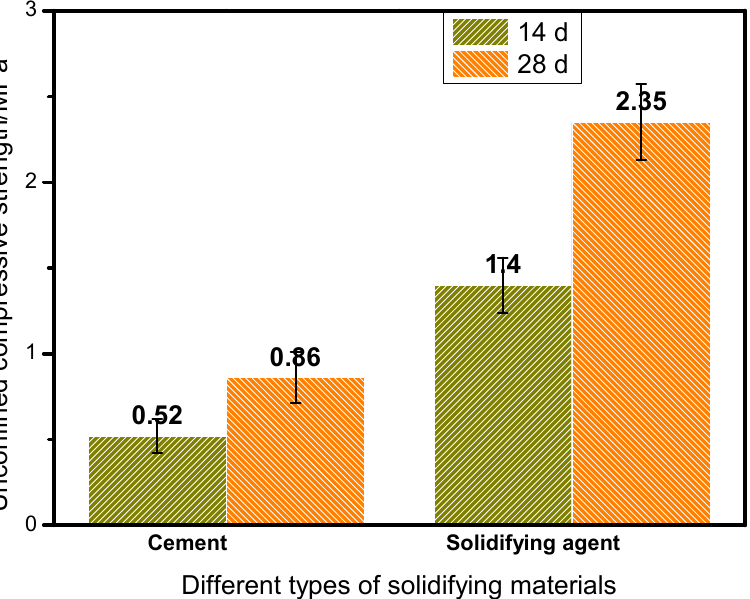
Figure 8. Effect of different types of solidifying materials on the unconfined compressive strength of a deep mixing